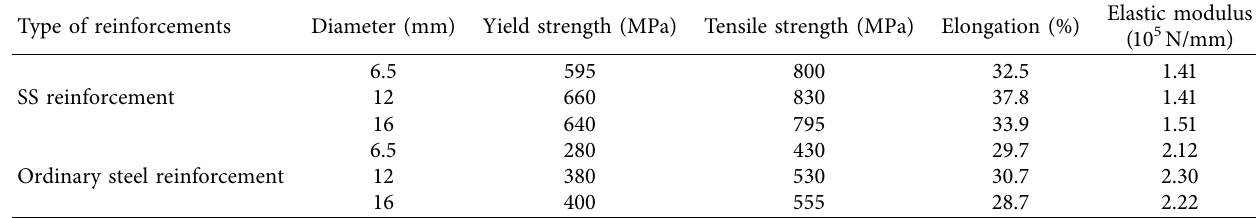
Table 1: Mechanical properties of reinforcements.